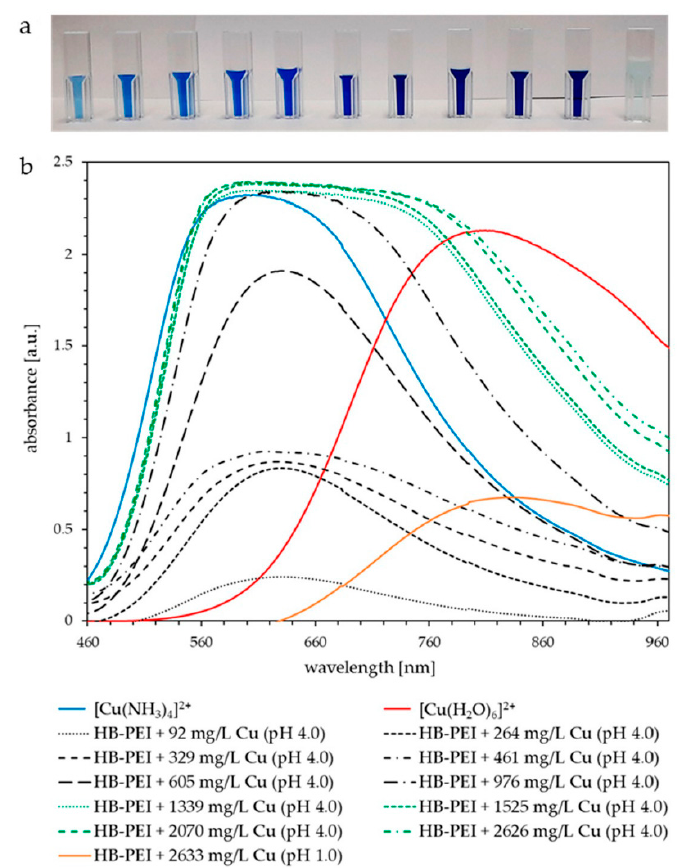
Figure 9. ( a ) PAUF feed samples of Cu(II) enrichment and final Cu(II) release (far right) from HB-PEI using fly ash extract (KEBAG Zuchwil), HB-PEI = 4.6 g L − 1 . ( b ) Corresponding UV-vis spectra of increasing Cu(II) loading (gray, black, and green graphs) and release (orange graph). Comparable solutions of [Cu(NH 3 ) 4 ] 2 + (blue graph) and [Cu(H 2 O) 6 ] 2 + (red graph) were additionally analyzed.